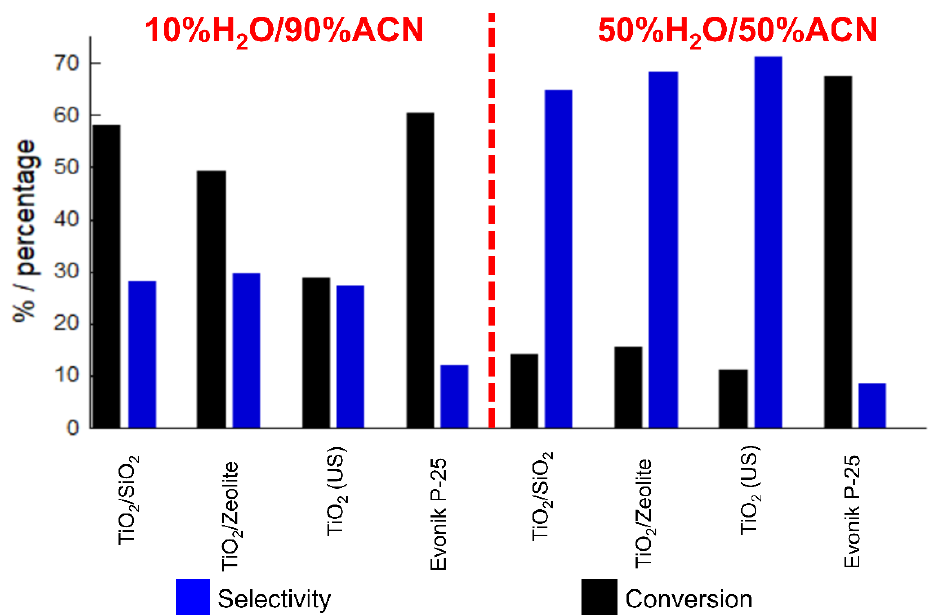
Figure 14. Effect of solvent composition on the conversion and selectivity of glucose to carboxylic acids using different TiO 2 photocatalysts, under 2.8 mM of glucose concentration, 150 mL of solu- tion, 150 mg of photocatalyst, 30 °C, 1 bar, and 10 min illumination time [42].